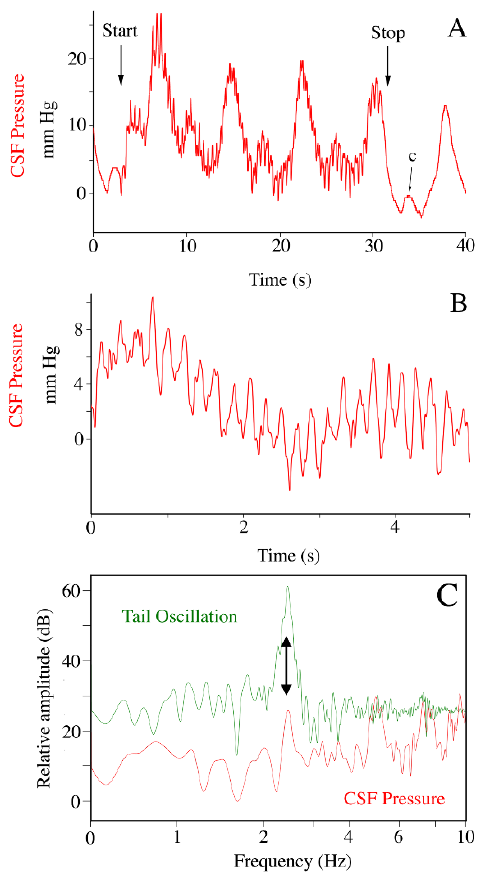
Figure 4. The influence of tail oscillations on CSF pressure. ( A ) The manual oscillation of the tail (vertical arrows) produced a distinct pattern of CSF pulsations (red) which obscured the cardiac- related pulsations, but were additive with the ventilatory-related pulsations. ( B ) Expanded time scale showing the higher frequency sinusoidal CSF pressure waves (red) recorded during tail oscillation. ( C ) Power spectral analyses of displacement of the tail (green) and the corresponding CSF pressure (red) recordings; note the overlap in the dominant frequencies (arrow), which (near 2.5 Hz) are well above the cardiac-related frequencies. c—individual cardiac-related pulsation.